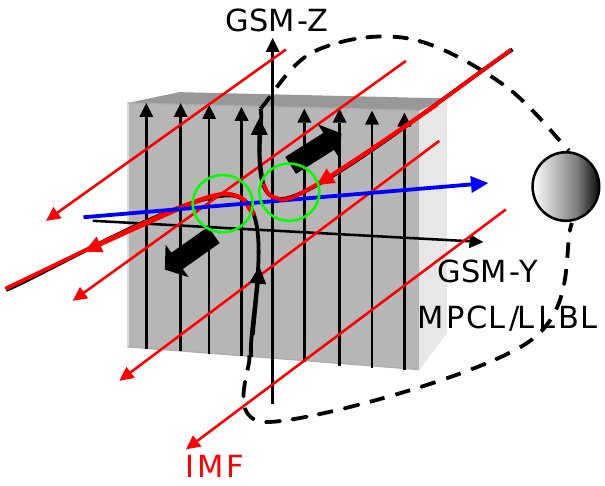
Fig. 7. A schematic illustration based on the results obtained from this observation as well as the primary picture of FTEs provided by Russell and Elphic (1978) (see Fig. 1). This illustration is viewed from the Sun. Thin arrows show the intrinsic magnetic field lines within the MPCL/LLBL, which are directed northward. The thin red arrows are the IMF directed dawn-southward. MPCL/LLBL magnetic field lines reconnected with the IMF are shown by the combination of thick black and red arrows. The thick black ar- rows show the movement directions of two reconnected flux tubes. The broken curves indicate that the magnetospheric sides of the re- connected field lines are anchored to the Northern/Southern Hemi- spheres. The blue arrow and two green circles show the approxi- mate satellite orbit and locations of the two MPCL